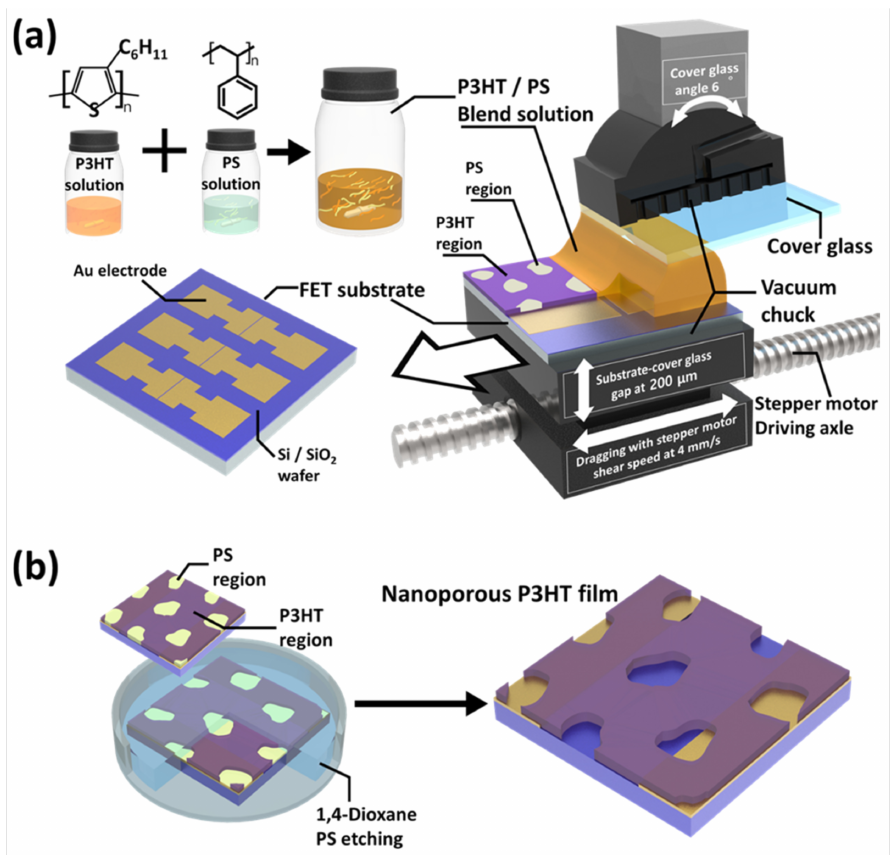
Figure 1. Schematic illustration of ( a ) the preparation of the poly(3-hexylthiophene) (P3HT)/polystyrene (PS) blend film (weight ratio = 70:30) and ( b ) the creation of the nanoporous P3HT (N-P3HT) film using the shear-assisted phase separation (SAPS) method and selective solvent